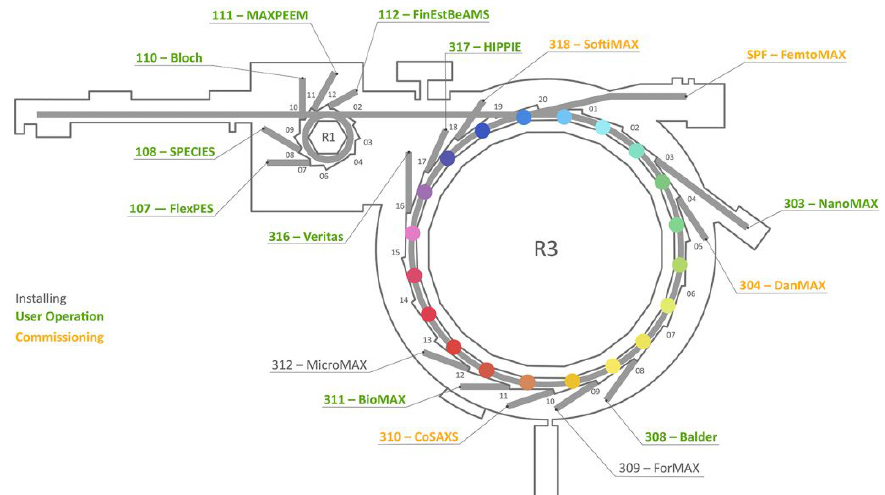
Figure 1. MAX IV floor plan showing beamlines and the storage